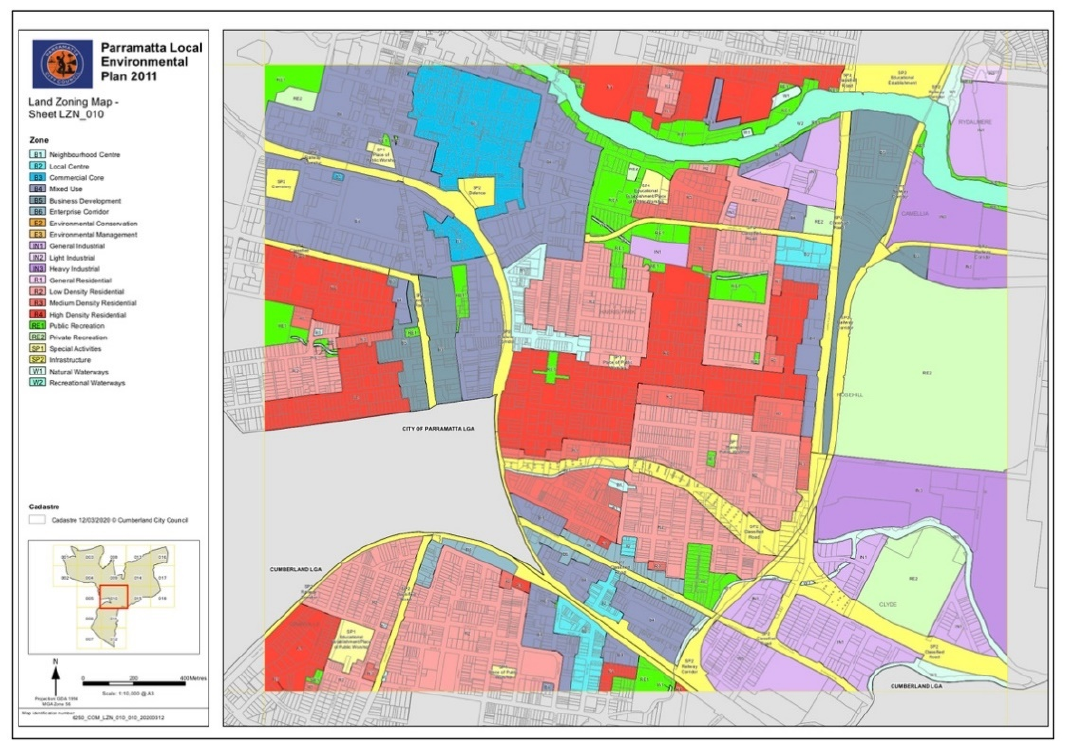
Figure A8. Parramatta Land Zoning Map LEP.